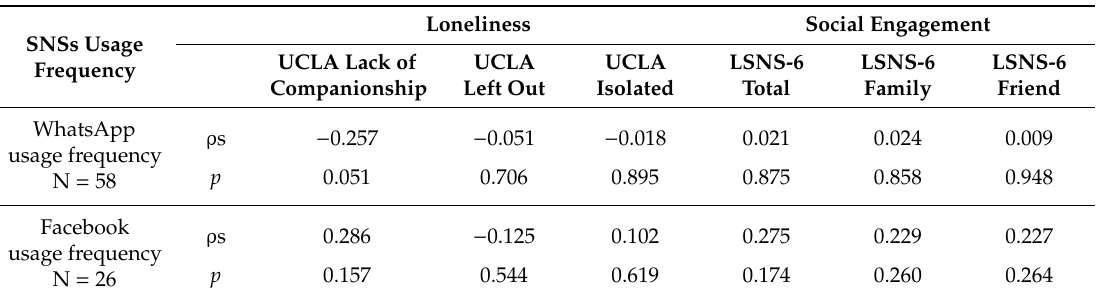
Table 3. Correlations between Social Networking Sites (SNSs) usage frequency and measures of loneliness and social